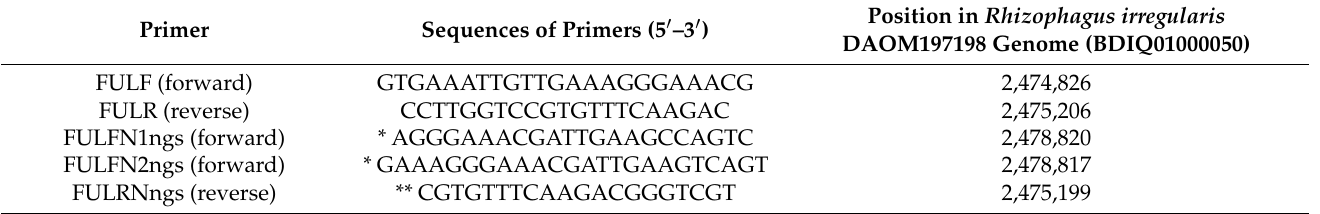
Table 3. List of primers designed to amplify the D2 fragment of fungal LSU rDNA. Position in Rhizophagus Primer Sequences of Primers (5 (cid:48) –3 (cid:48) )